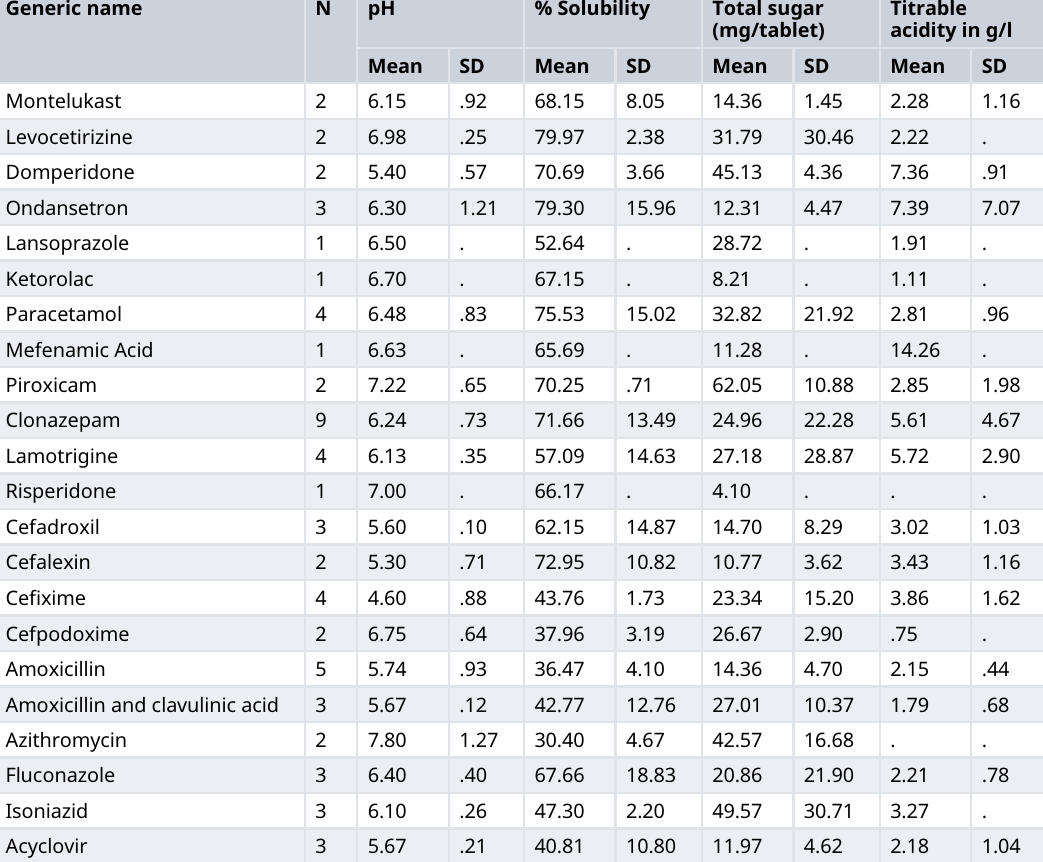
Table 1. Distribution of potential of hydrogen (pH), solubility, titratable acidity (TA), and total sugar content (TSC) of different generic formulations of orodispersible